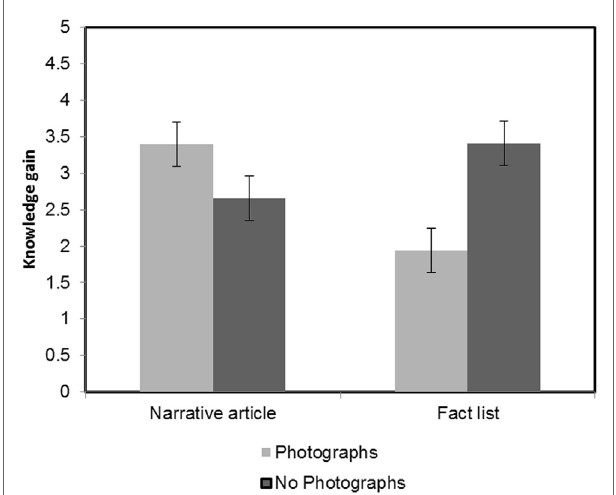
FigUre 2 | Interaction effect of text type (narrative article vs. fact list) and visualization (photographs vs. no photographs) on knowledge gain as the difference between knowledge posttest and knowledge pretest. Error bars represent SEs.